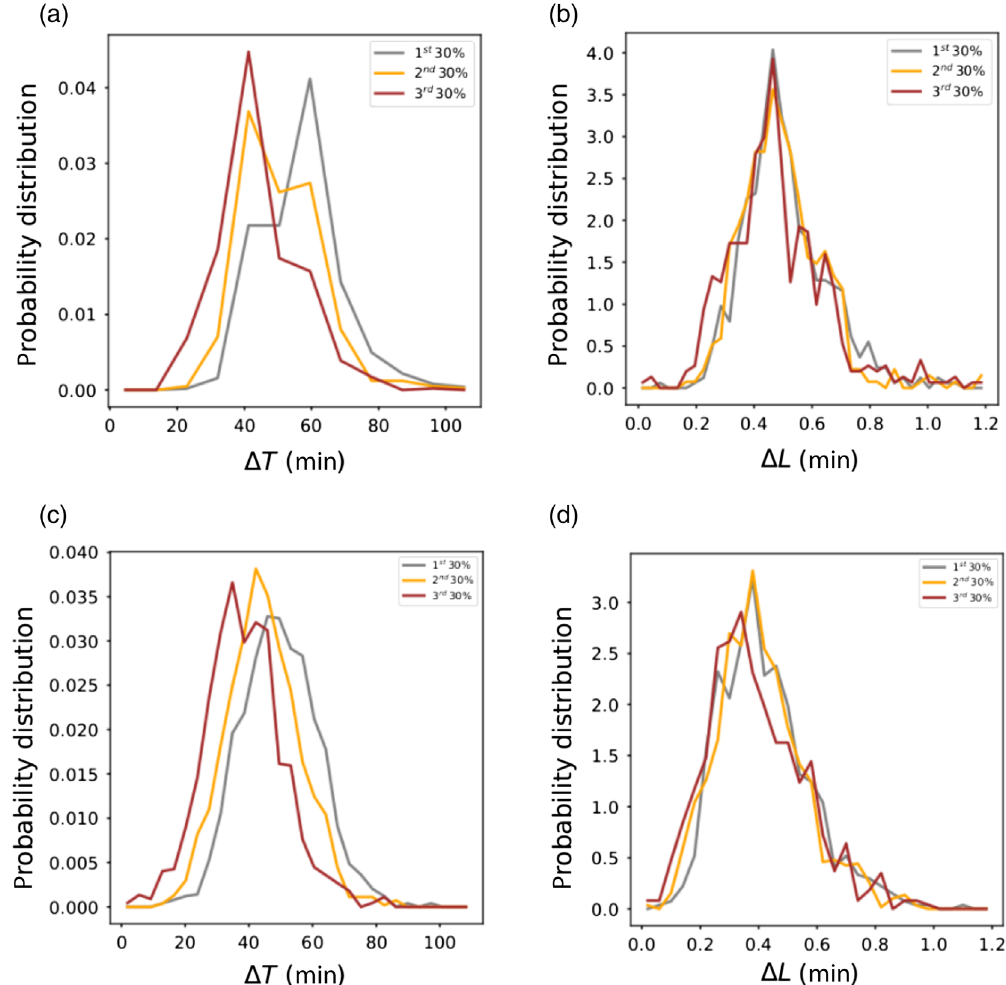
FIG. 9. Conditional distributions in experiments and model. (a),(b) The distributions of the division time ( Δ T ) and the length elongation ( Δ L ) when the size at birth L 0 is in three different percentiles from experimental measurements. The corresponding distributions from model results are shown in